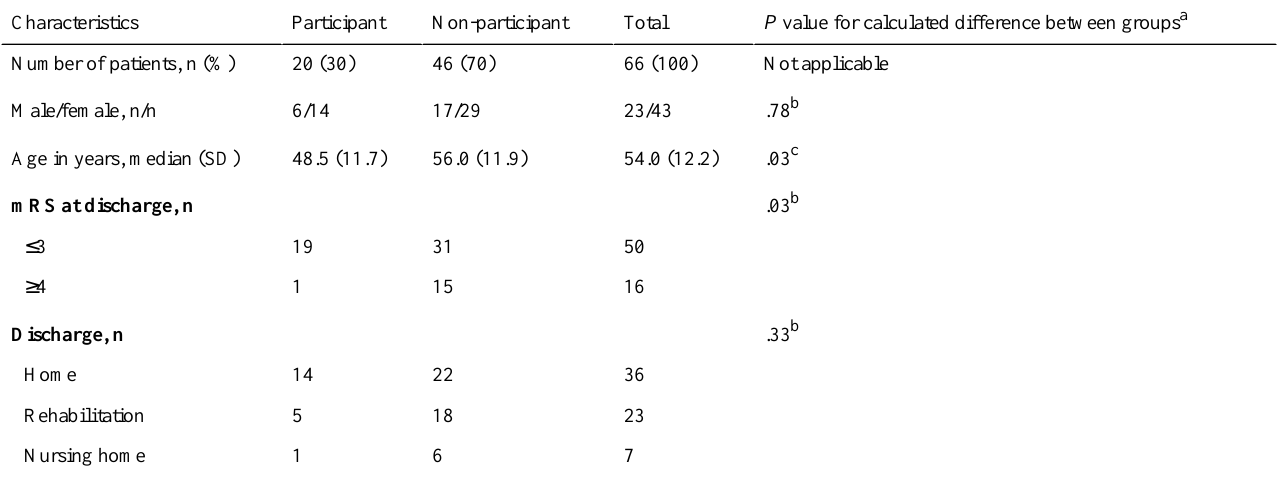
Table 1. Patient characteristics.